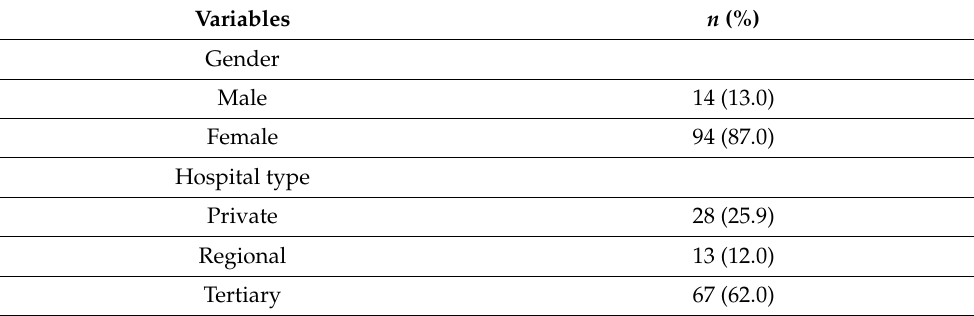
Table 1. Demographic characteristics of the